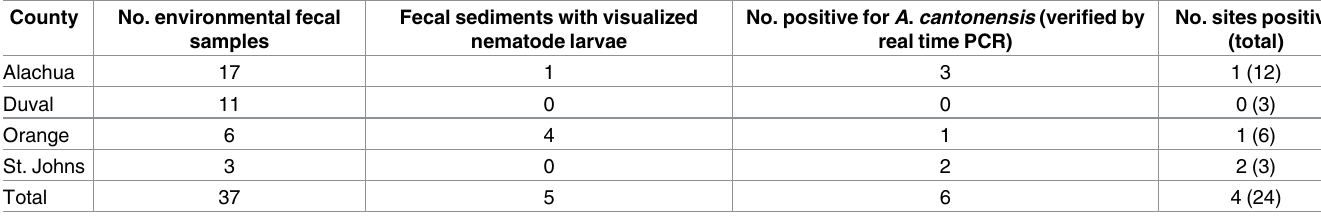
Table 2. Rat environmental fecal samples collected from multiple sites in 4 counties in Florida. County No. environmental fecal